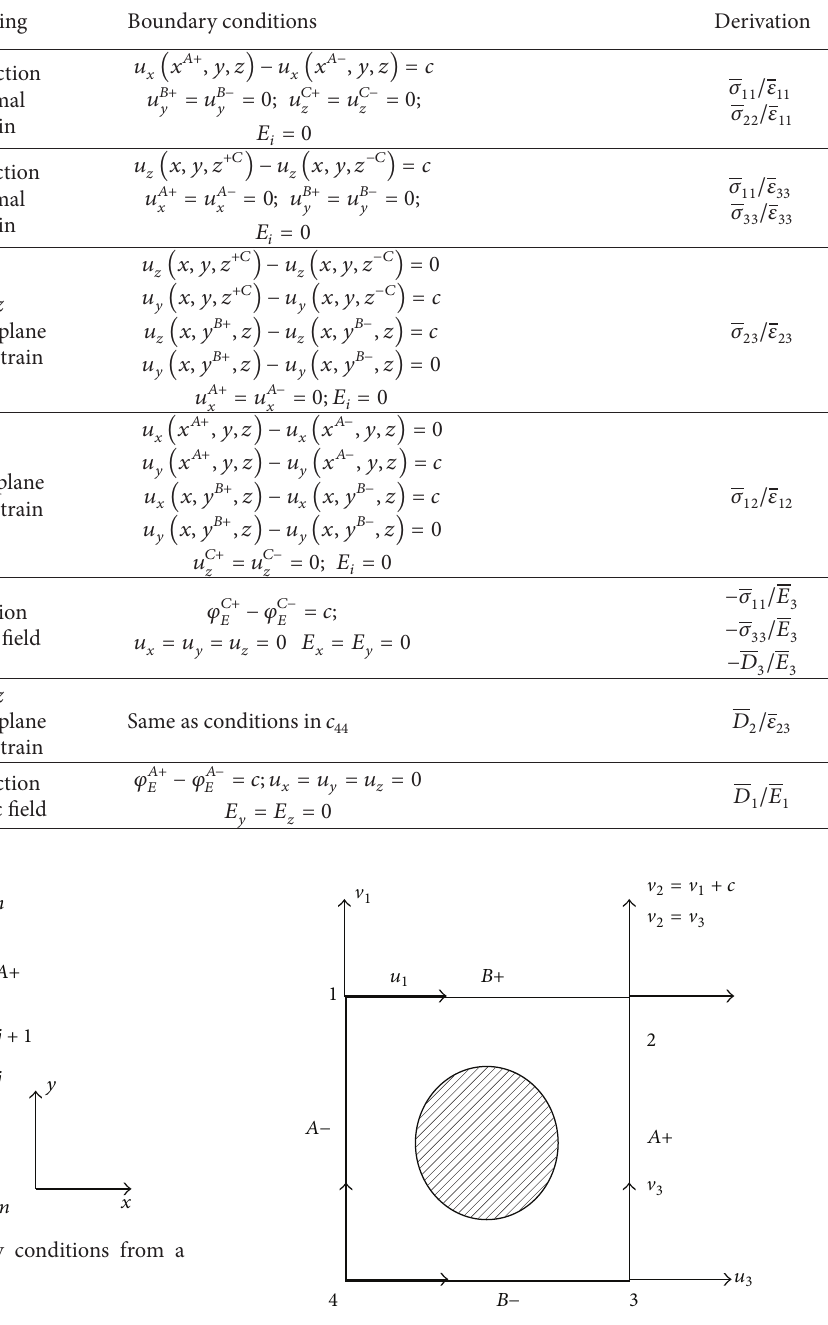
Figure 4: Overconstraint situations for 2D